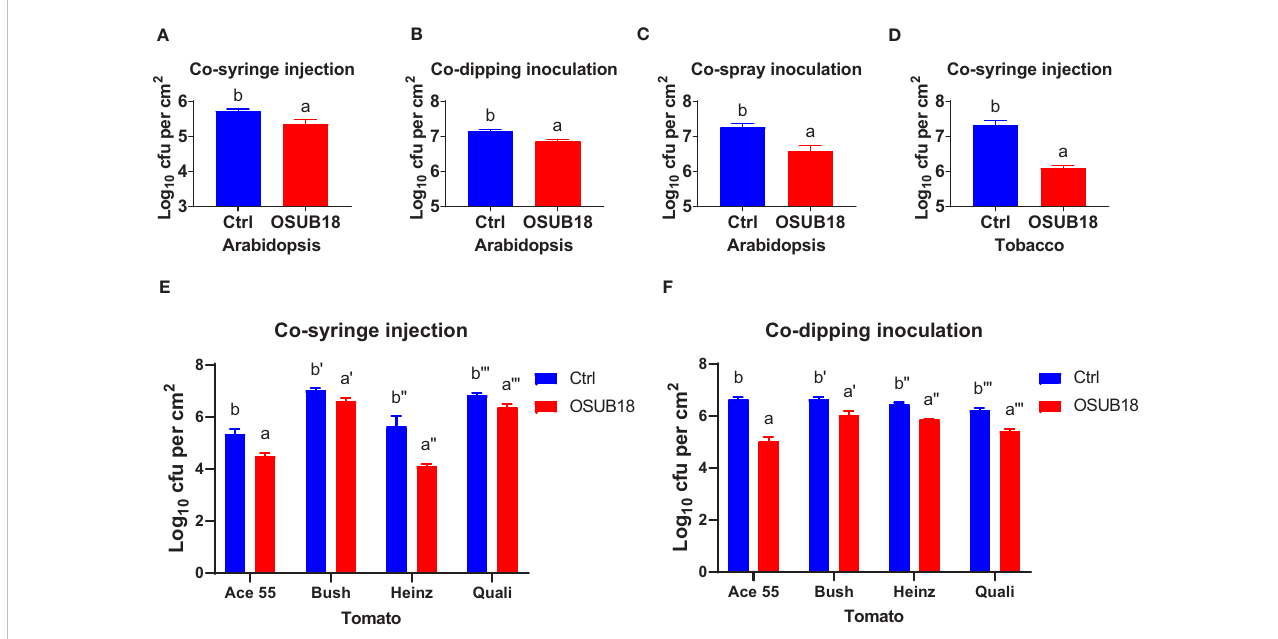
FIGURE 2 OSUB18 co-inoculation protected plants of different species from the bacterial pathogen Pst DC3000 infections. (A – C) OSUB18 inhibited Pst DC3000 growth in A thaliana Col-0 leaves after co-syringe injection (A) , co-dipping inoculation (B) , or co-spray inoculation (C) . (D) OSUB18 inhibited Pst DC3000 growth in tobacco leaves after co-syringe injection. (E, F) OSUB18 inhibited Pst DC3000 growth in tomato leaves of diverse cultivars after co-syringe injection (E) or co- dipping inoculation (F) . An equal volume of water (Ctrl) or OSUB18 was mixed into the Pst DC3000 (cell) inoculum for the phytopathogenic infection assay. Data present mean ± SE of three biological replicates. Data with different letters indicate a p- value < 0.05 on Student ’ s